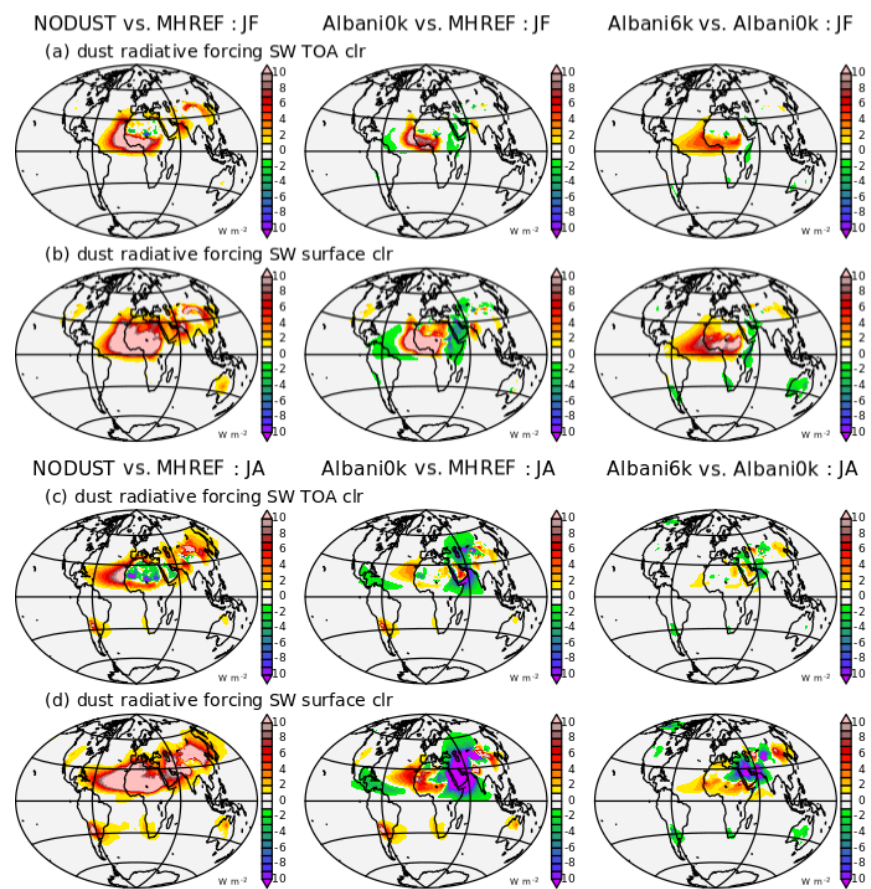
Figure 10. Comparisons of the radiative forcing (Wm − 2 ) induced by the different dust fields at (a, c) the top of the atmosphere (TOA) and (b, d) the surface for (a, b) January–February (JF) and (c, d) July–August (JA) averages. The radiative forcing has been estimated from online atmosphere alone simulations following the RFMIP protocol (see text). The left and middle columns represent respectively the difference between the NODUST (left) and Alanani0k (middle) estimates compared to the Mid-Holocene reference simulations (MHREF), and the right column represents the difference between the Albani6k and the Albani0k estimates. All fields are positive down to directly reflect the radiative budget at TOA or at the